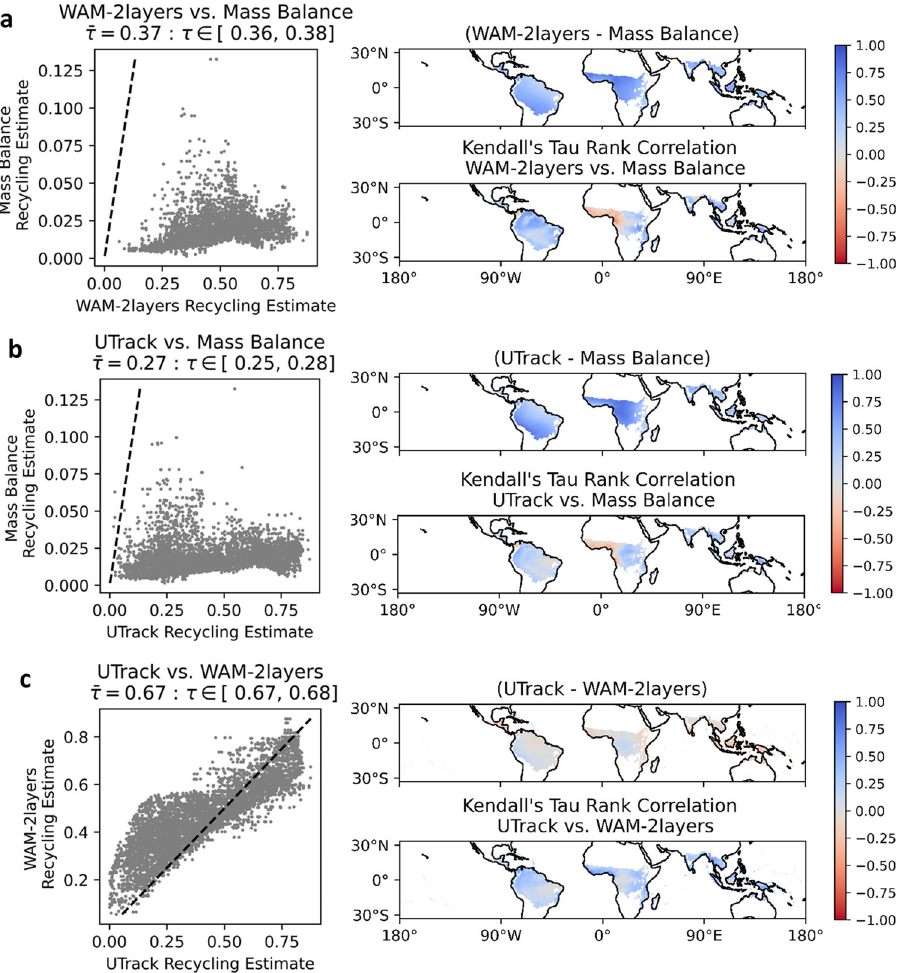
Fig. 2 Model intercomparison of moisture recycling estimates. The scatter plots shown above represent the grid-by-grid comparison of mean annual estimates of the recycling ratio for the entire 2002 – 2018 analysis period, where the black dashed line indicates a 1:1 correspondence. The right panel includes two plots per model comparison: the difference in mean annual estimates for the two models (top) and corresponding rank-based time-series cross-correlation between model estimates (bottom). Panel ( a ) shows WAM-2layers vs. Mass Balance, panel ( b ) shows UTrack vs. Mass Balance, and panel ( c ) shows UTrack vs.